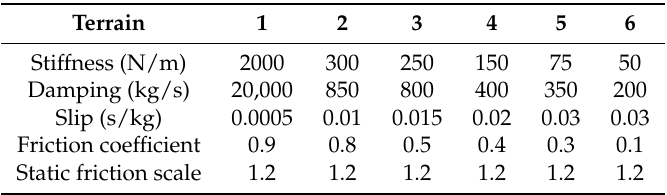
Table 3. Terrain